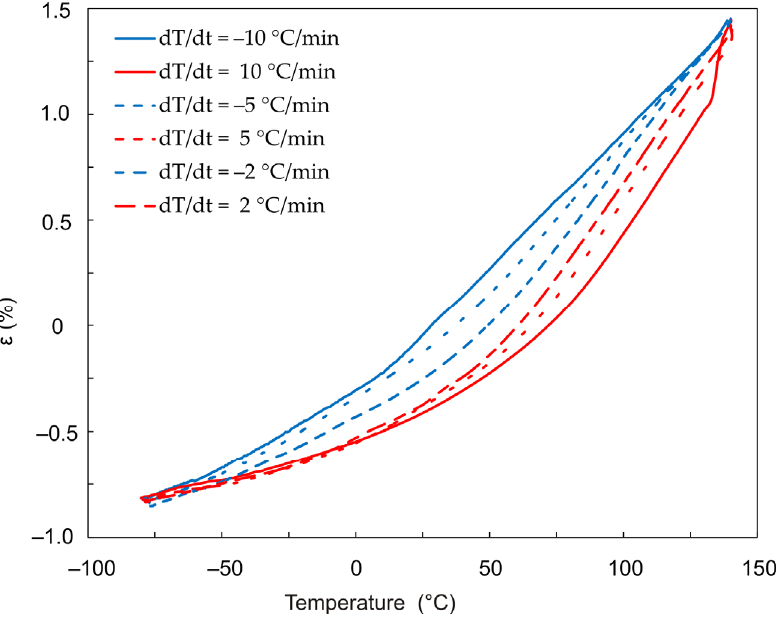
Figure 12. Temperature dependence of strain for 42 μ m DeSolite DS-2015 polymer specimen with different cooling/heating rates: 10 °C/min (heating—solid red line/cooling—solid blue line); 5 °C/min (red/blue dash line); 2 °C/min (red/blue dash-dot line).